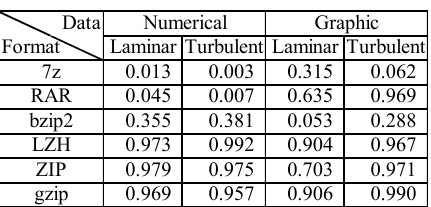
Table 1 NCD between same data Table 2 Difference of NCD( X , Y ) and NCD( Y , X )